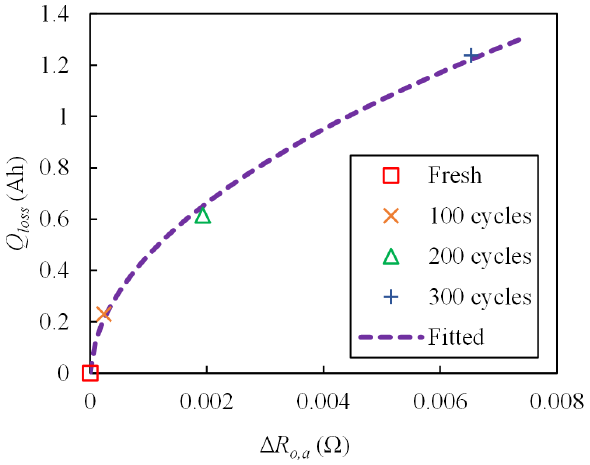
Figure 6. The relationship between Δ R o,a and Q loss